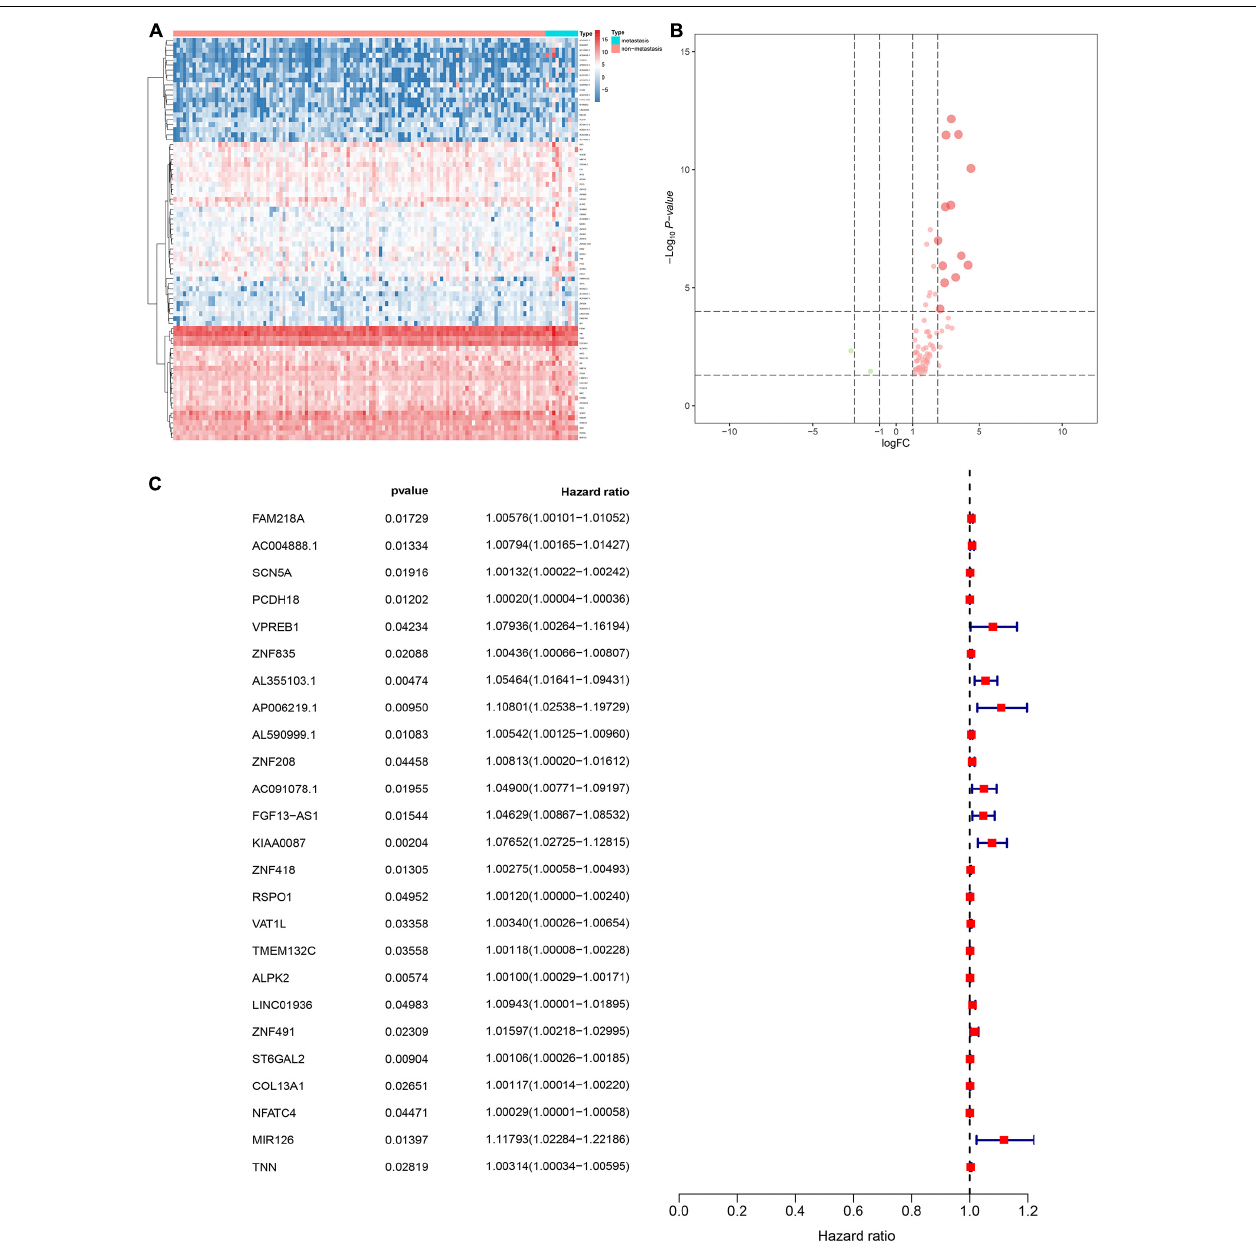
FIGURE 4 | Heat map for the differentially expressed stemness-related genes (DESRGs) between 10 metastatic and 116 non-metastatic patients with CESC (A) . Volcano plot for DESRGs between 10 metastatic and 116 non-metastatic patients with CESC (B) . The proportional hazards model based on 25 key DEMRGs (C).